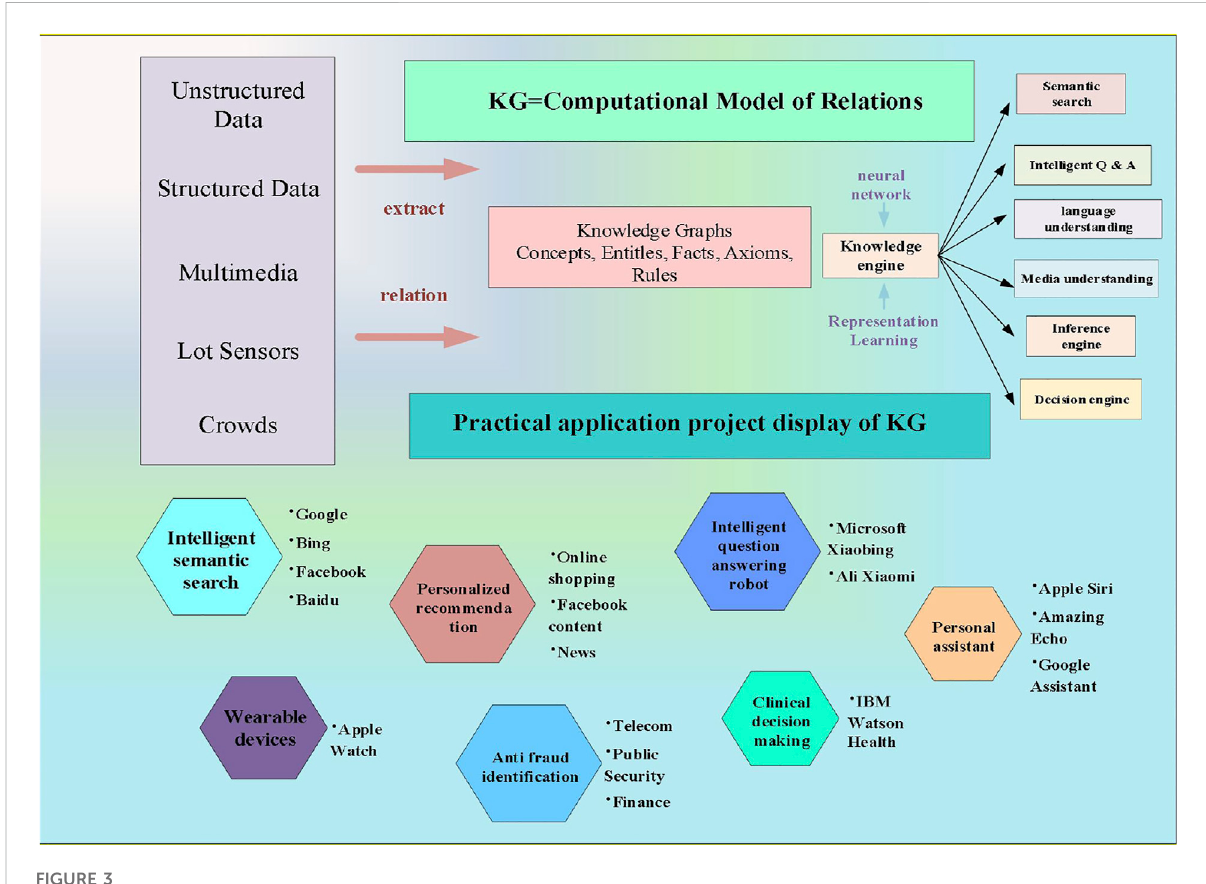
FIGURE 3 Overview of the connection and application between things in